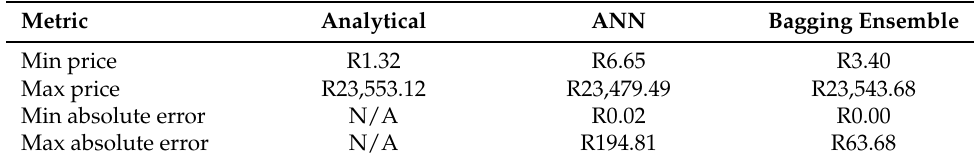
Table 7. Magnitude of errors: fully collateralized.